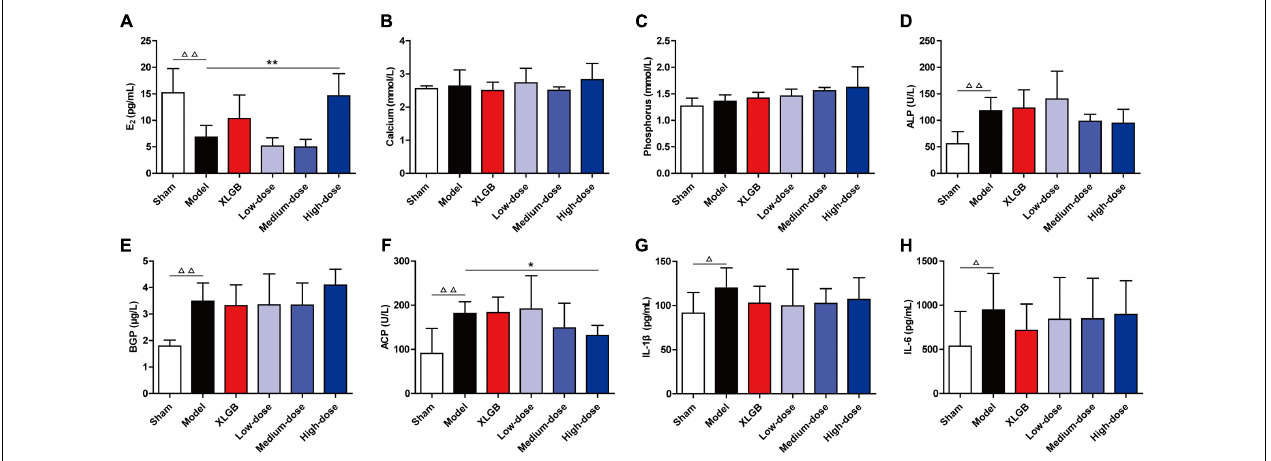
FIGURE 1 | Pu-erh tea extract (PTE) ameliorated blood biochemical indicators in OVX rats. Serum E 2 (A) , calcium (B) , phosphorus (C) , alkaline phosphatase (ALP) (D) , bone gla protein (BGP) (E) , and acid phosphatase (ACP) (F) , as well as plasma IL-1 β (G) and IL-6 (H) concentrations in each group. All data are presented as the mean ± SEM ( n = 10). (cid:77) P < 0.05 and (cid:77)(cid:77) P < 0.01 versus the sham group; and ∗ P < 0.05 and ∗∗ P < 0.01 versus the model group.